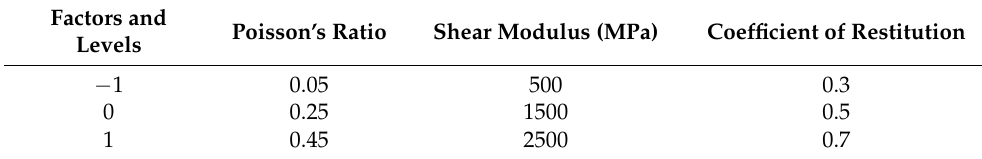
Table 4. Factors and levels of the Box—Behnken